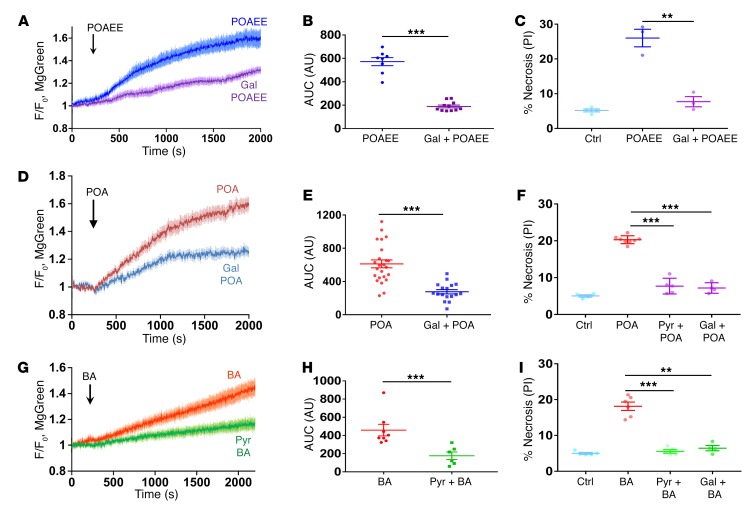
Pyruvate and galactose provide substantial protection against alcohol- and bile-induced ATP loss and necrosis in PACs.(A) POAEE-induced (500 μM) ATP depletion is markedly reduced by adding 1 mM galactose (Gal). Averaged normalized (F/F0) traces with error bars (POAEE, n = 8; galactose + POAEE, n = 11). (B) AUC comparison of traces shown in A. Galactose-reduced POAEE-induced ATP depletion (P < 0.0001, 2-tailed Student’s t test). (C) POAEE-induced necrosis was significantly reduced by adding 1 mM galactose (P < 0.003, 1-way ANOVA; 3 series of experiments with more than 100 cells in each sample). (D) POA-induced (50 μM) ATP depletion is reduced by replacing glucose with 10 mM galactose. Averaged traces with error bars (POA, n = 24; galactose + POA, n = 17). (E) AUC comparison of traces shown in D. Galactose significantly reduced POA-induced ATP depletion (P < 0.0001, 2-tailed Student’s t test). (F) POA-induced necrosis was reduced significantly by replacing glucose with either 10 mM pyruvate (Pyr) or 10 mM galactose (P < 0.0001 in both series, 1-way ANOVA; dots represents a series of experiments with more than 100 cells in each sample). (G) BA mixture–induced ATP depletion is reduced by adding 1 mM pyruvate. Averaged traces with error bars (BA, n = 8; BA + pyruvate, n = 6). (H) AUC comparison of traces shown in G. Pyruvate significantly reduces BA-induced ATP depletion (P < 0.002, 2-tailed Student’s t test). (I) BA-induced necrosis is reduced to nearly control level by replacing glucose with 10 mM pyruvate (P < 0.00015, 1-way ANOVA; 5 series of experiments with more than 100 cells in each sample) or 10 mM galactose (P < 0.008, 1-way ANOVA; 4 series of experiments with more than 100 cells in each sample). **P < 0.01; ***P < 0.001, 2-tailed Student’s t test (B, E, H); 1-way ANOVA (C, F, I).